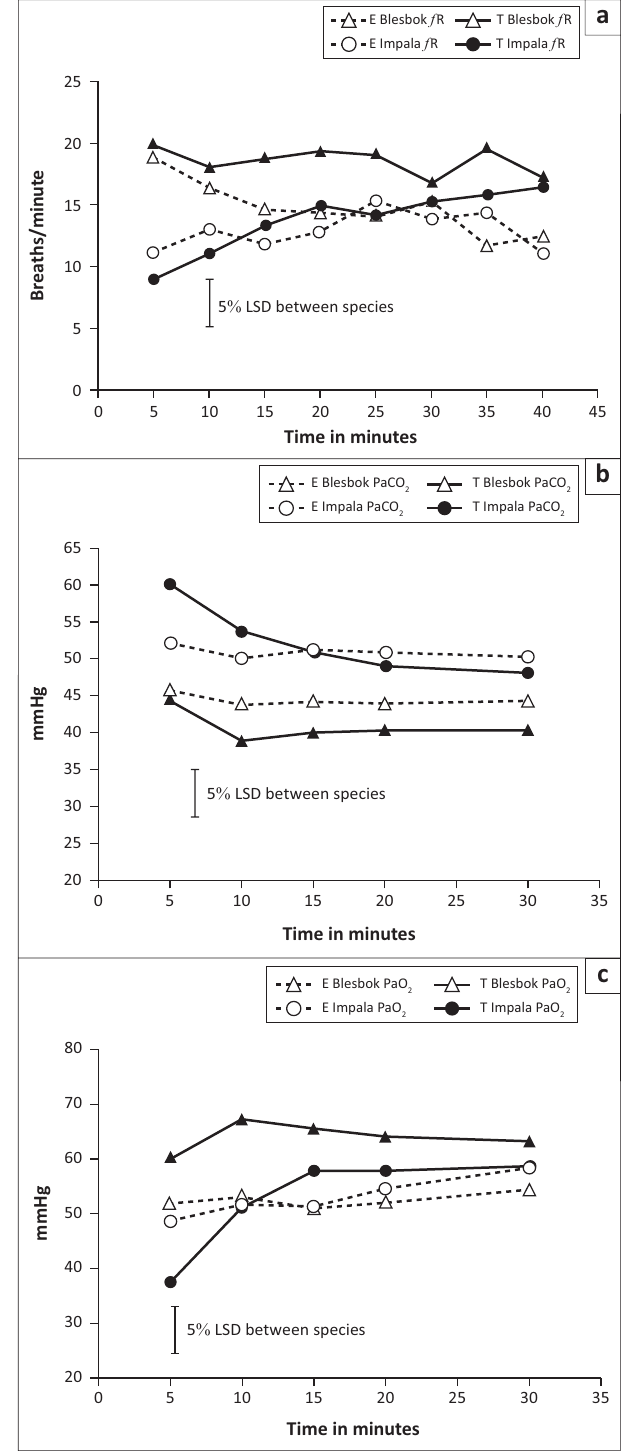
FIGURE 2: Respiratory rate in breaths/minute (a), PaCO mmHg over time (minutes) of blesbok ( Damaliscus pygargus phillipsi ) and impala ( Aepyceros melampus ) immobilised with 0.09 mg/kg etorphine (E) or thiafentanil (T) respectively. Time was measured from when an animal became recumbent as a result of the